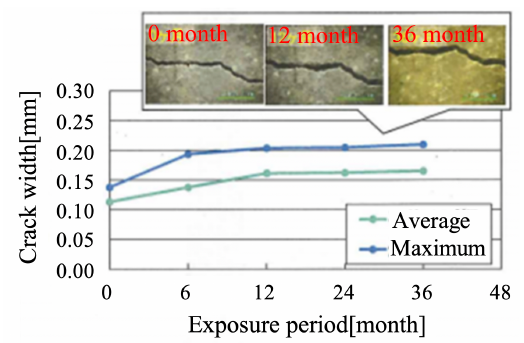
Figure 10. Crack width measurement result of CP500 utility poles using IQT-S as tendon.